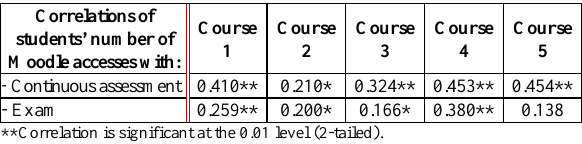
STUDENTS ’ ACESSES AND GRADES : P EARSONS ’